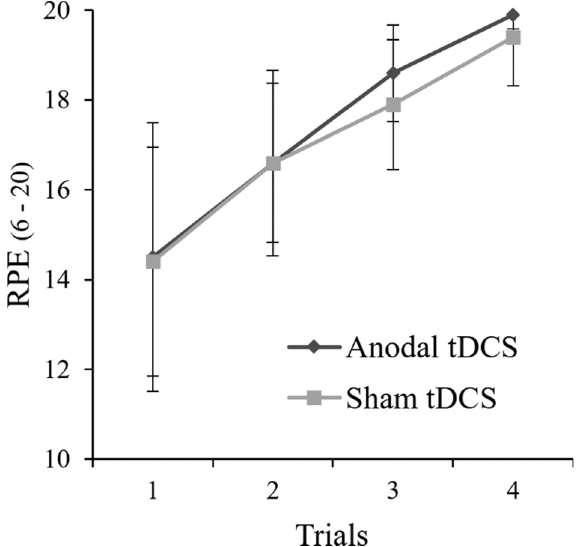
Figure 3 - Rating of Perceived Exertion (RPE) after each Wingate trial for anodal and sham